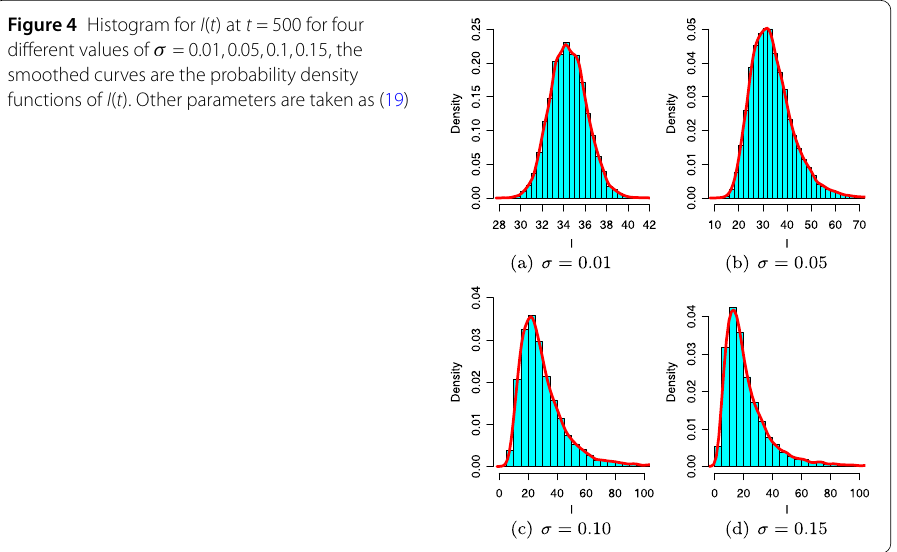
Figure 4 Histogram for I ( t ) at t = 500 for four different values of σ = 0.01,0.05,0.1,0.15, the smoothed curves are the probability density functions of I ( t ). Other parameters are taken as